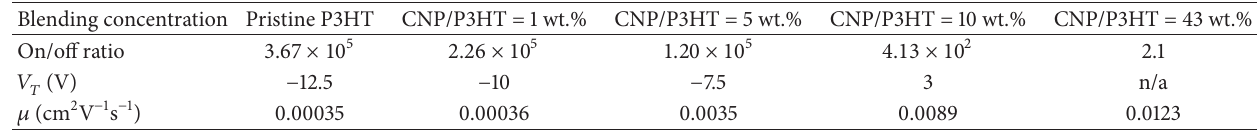
) measurement as a function of channel length with various 𝑉 Figure 4: On resistance (𝑅 on 5 wt.% OTFTs. Table 1: Electrical properties of fabricated